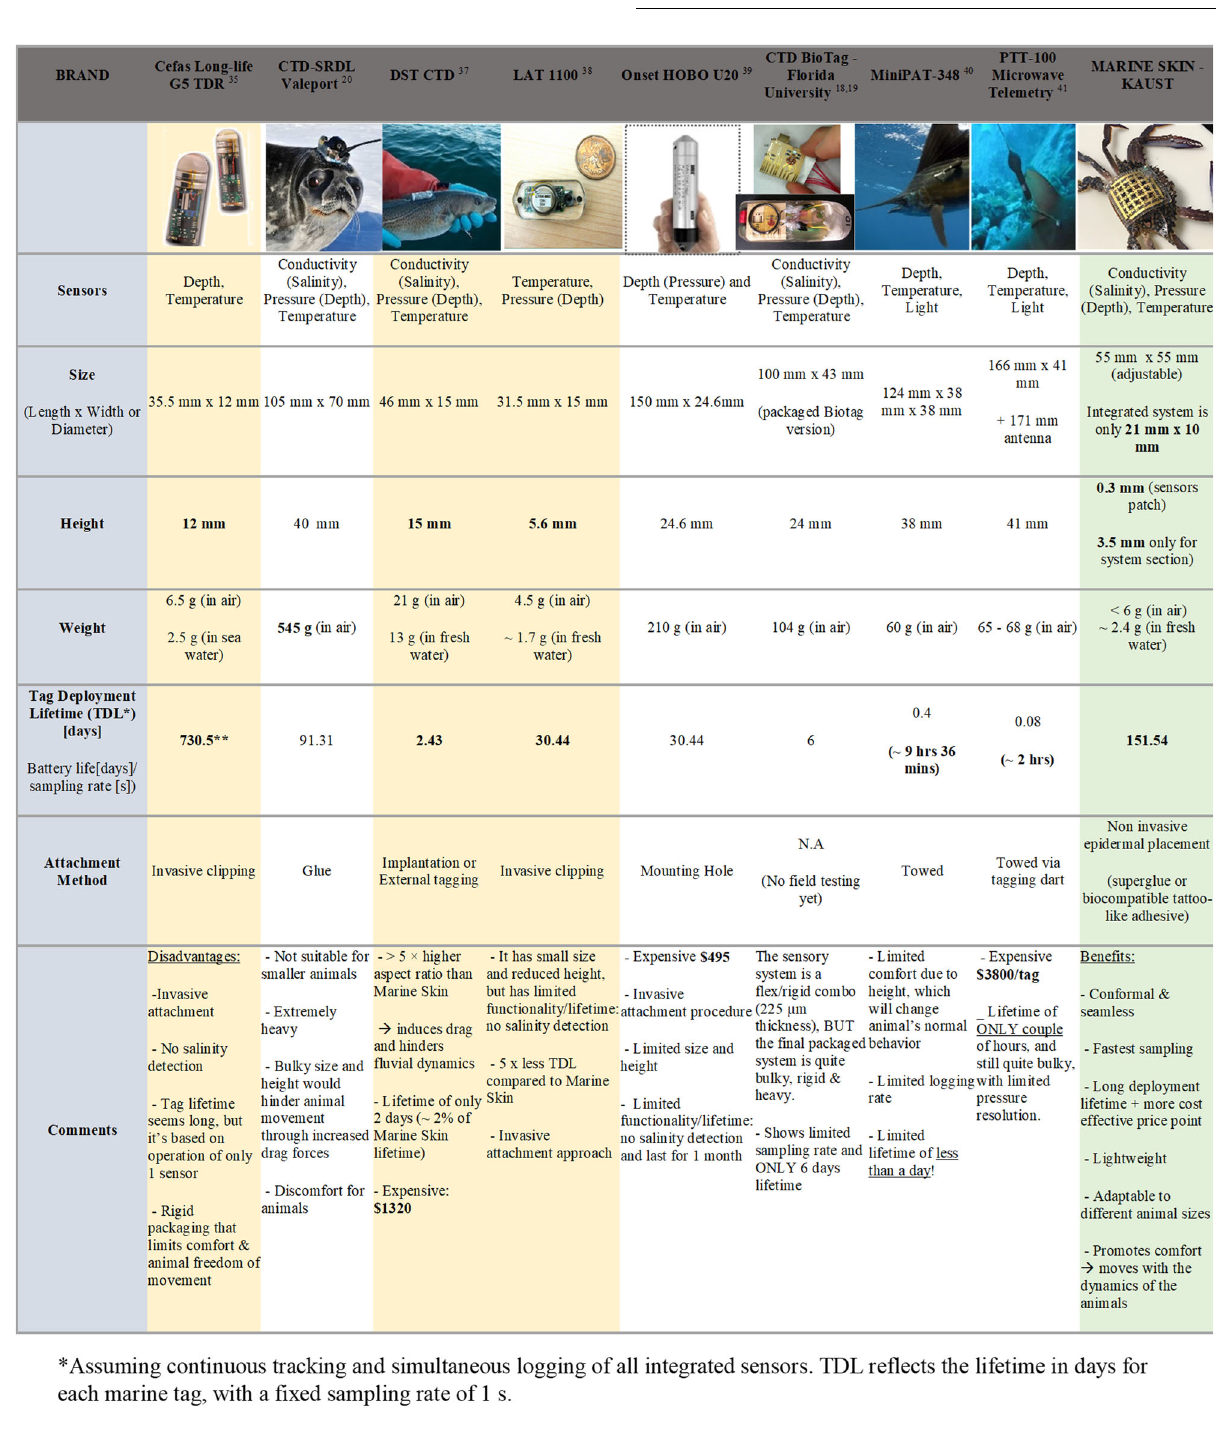
Fig. 6 Benchmarking of marine tags. Table comparing Marine Skin form factor metrics to industry best marine tags as well as academia based marine tag developments with similar sensory